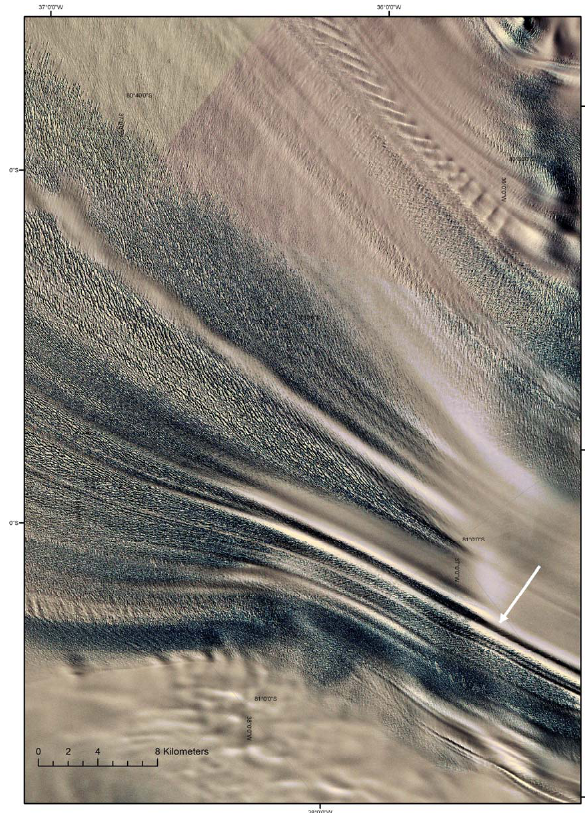
Figure 6. Close up of portion of tributary glacier to Recovery Glacier from Fig. 6. Close up of portion of tributary glacier to Recovery Glacier LIMA showing detail of longitudinal structures, including their trough from LIMA showing detail of longitudinal structures, including morphology (arrowed). Location of Figure is marked on Fig. 5. their trough morphology (arrowed). Location of figure is marked on Fig. 5.